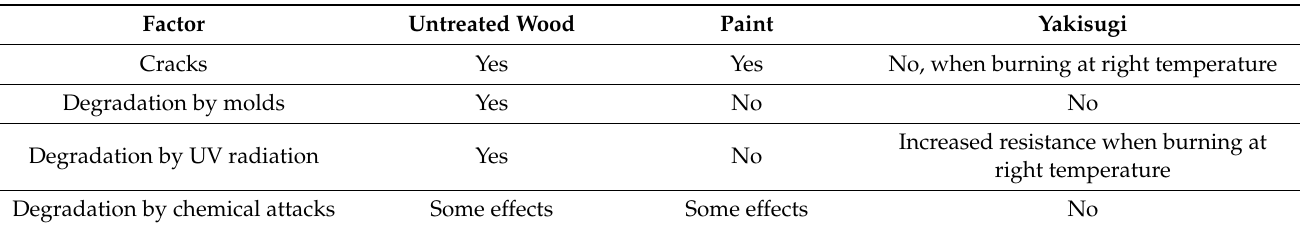
Table 2. External factors and their effect on untreated and surface-treated wood in terms of durability, provided that periodic maintenance is